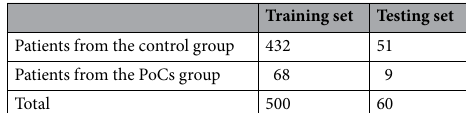
Table 6. Distribution of patients in the training set and the testing